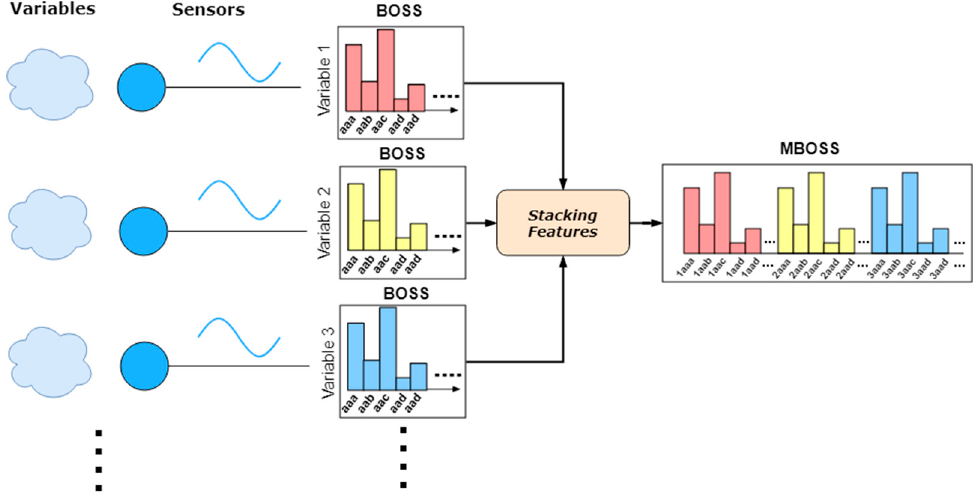
Figure 4. Data fusion at the features level: Example of concatenation of histograms (Feature Stacking).